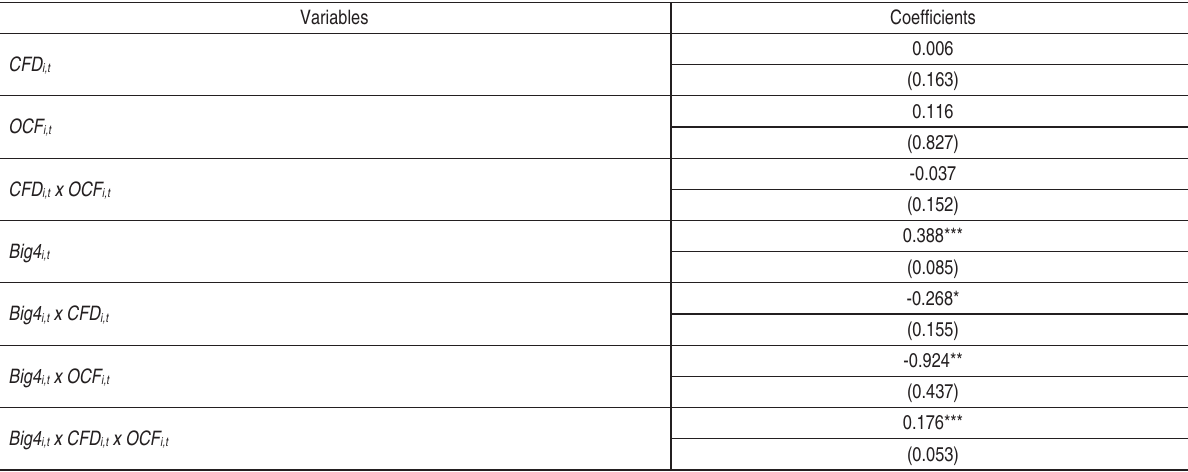
Table 3. Conservatism and Big 4 auditing (equation